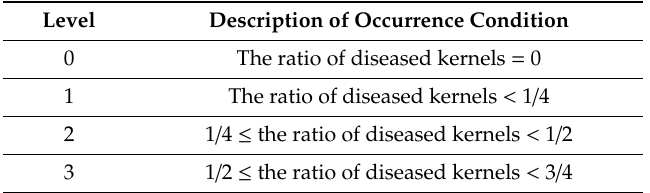
Figure 2. FHB-infected ear of winter wheat at di ff erent stages of severity. Figure 2 . FHB-infected ear of winter wheat at different stages of severity. Table 1. The grading standards of wheat Fusarium head blight (FHB) occurrence